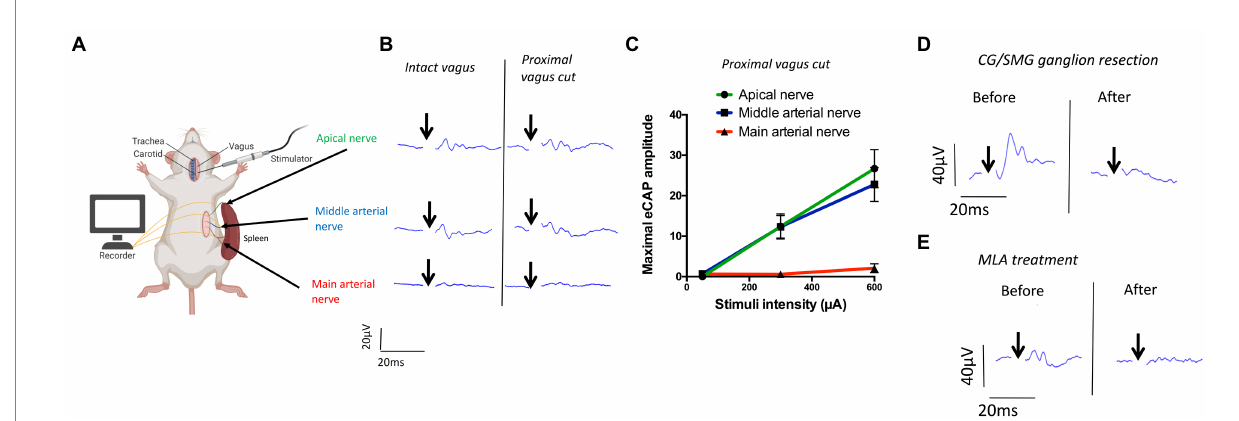
FIGURE 1 Efferent vagus nerve is connected to the splenic nerves. (A) Mice were anesthetized, a hook electrode was placed on the left vagus nerve and a platinum-iridium recording electrodes were placed onto the apical, middle or main branches of the splenic nerve for evoked compound action potential recording. Representative (of 4 mice) (B) and maximal amplitudes (C) of evoked compound action potential recordings (average of 100 sweeps) in the indicated tissues after vagus nerve stimulation (VNS). Stimulation artefacts are indicated by arrow. (C) Mean ± SEM. Representative (of 3 mice). (D,E) CAP recordings in middle arterial splenic nerve after either coeliac superior mesenteric ganglion (CG/SMG) cauterization (D) or